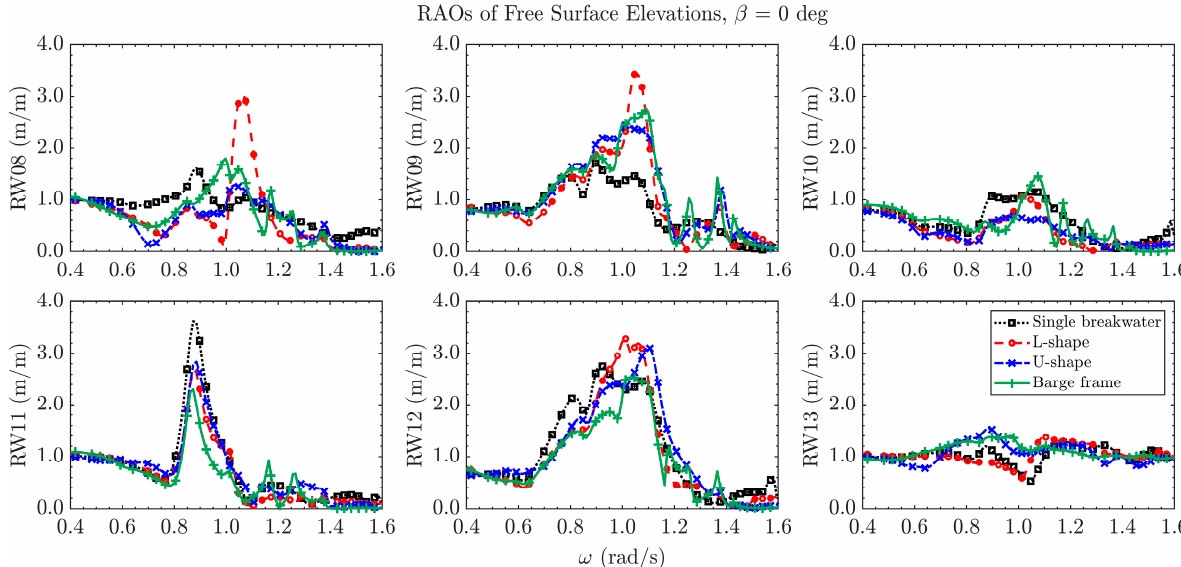
Figure 16. Motion RAOs of free surface elevations around the floating tanks with the different configurations of floating breakwaters in 0 deg wave direction.